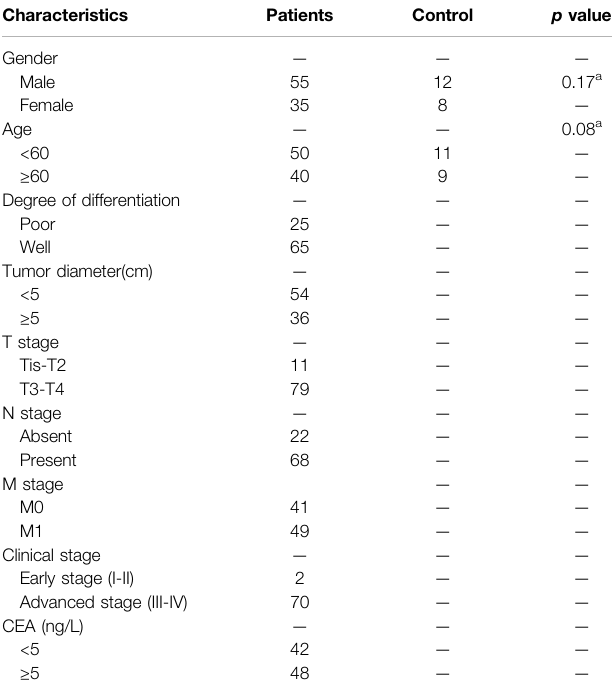
TABLE 2 | Baseline characteristics of 90 CRC patients and healthy controls.